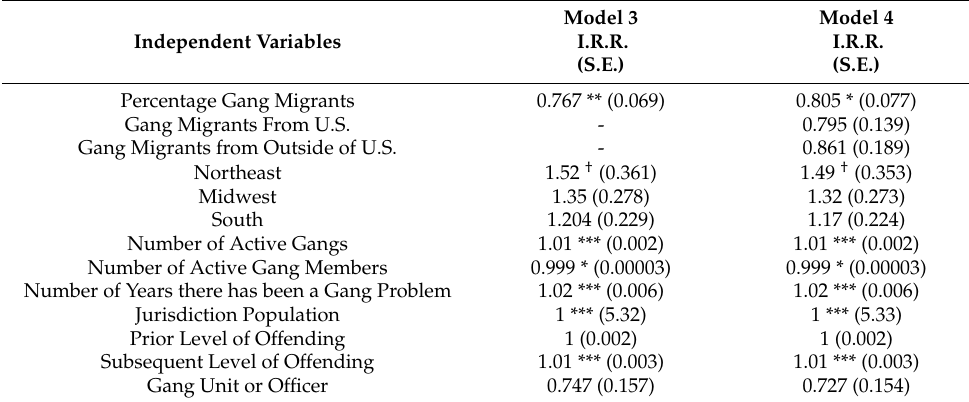
Table 4. Percentage Gang Migrants and Gang-Related Homicides (n =